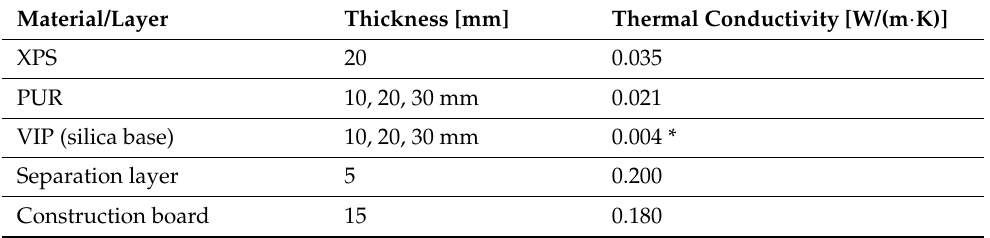
Table 1. Material parameters considered for the calculation (typical values given by the manufacturers of the given materials).